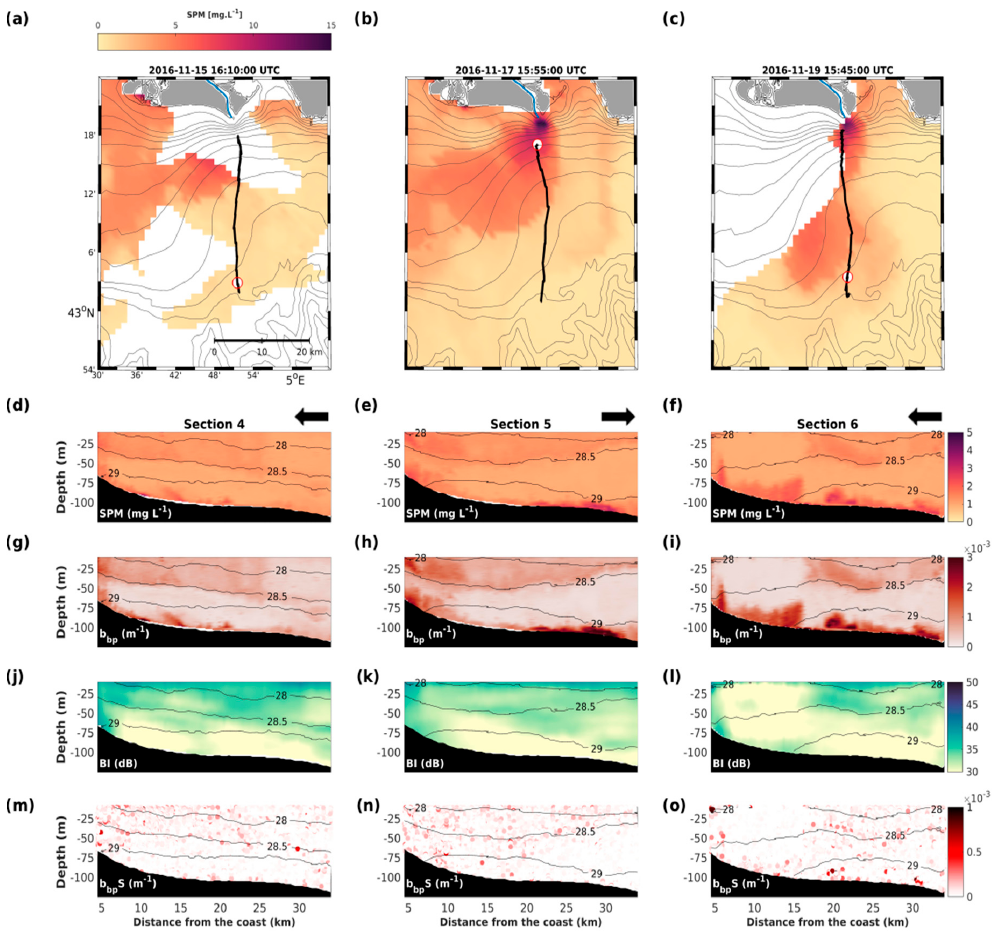
Figure 11. Surface turbidity from MODIS images ( a – c ) and glider measurements in the autumnal season: ( d – f ) suspended particle matter, ( g – i ) optical backscattering, ( j – l ) acoustic backscatter index, and ( m – o ) optical backscatter spikes. The left panels are estimates for Section 4, from 15–17 November 2016. The center panels are estimates for Section 5, from 17–18 November 2016. The right panels are estimates for Section 6, from 19–21 November 2017. The black arrows indicate the glider’s direction. For the top panels, the glider’s location at the time the satellite image was taken is shown by the red circle, and clouds and land are shown as white patches and gray areas,